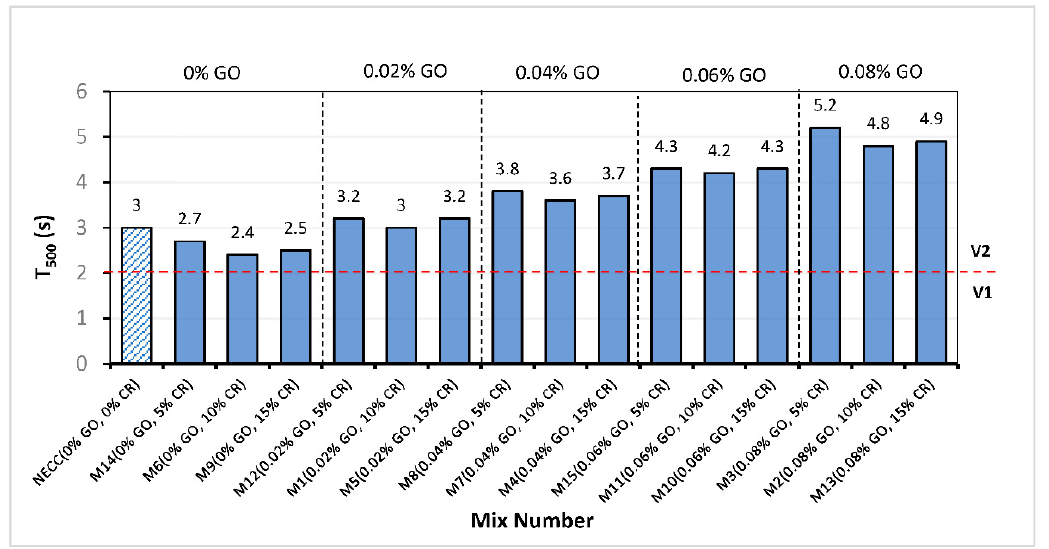
Figure 4. T 500 for all